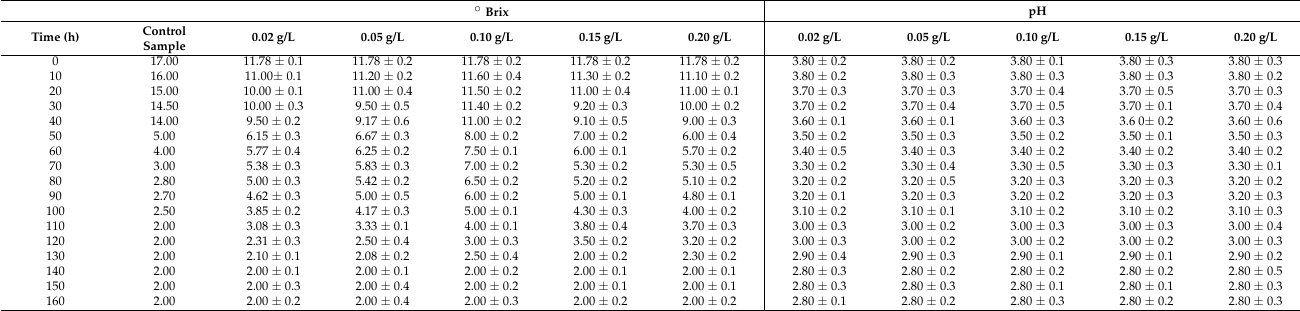
Table 2. Quantification of degrees Brix and pH for samples at different concentrations.